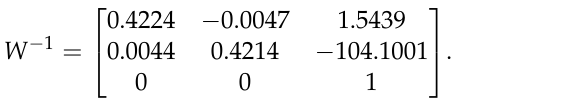
Figure 5. Source and scanned image landmarks (joint space).